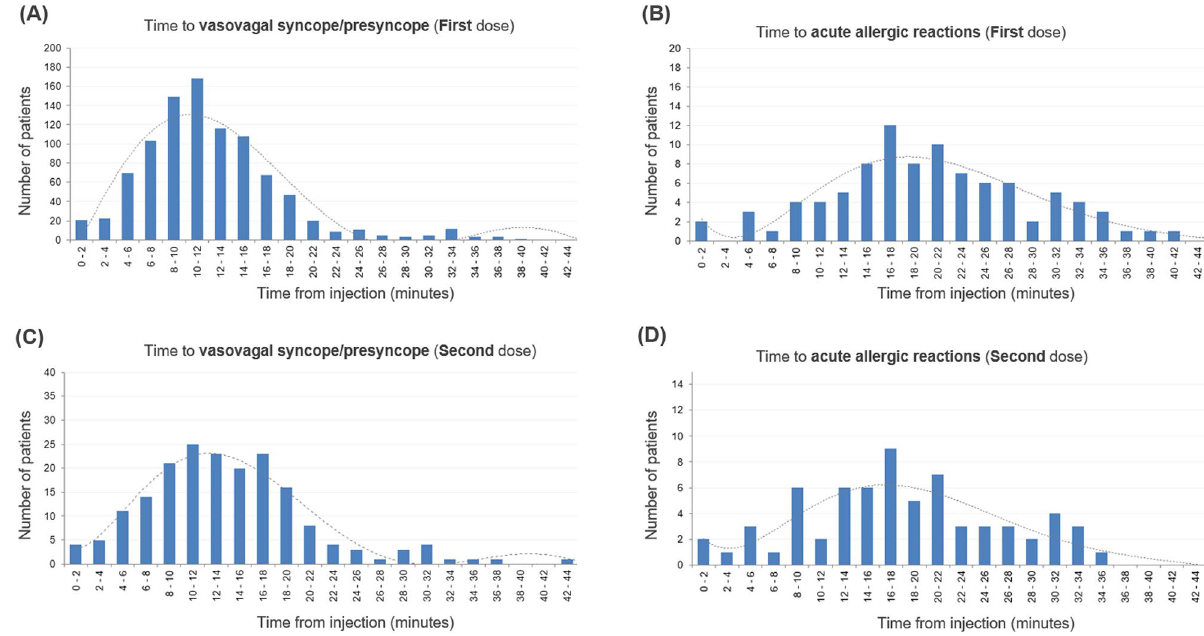
Figure 3. Timing of acute adverse event by age group. Histograms for the time from the vaccine injection to the occurrence of the acute adverse events after the first vaccine dose ( A , B ) and after the second vaccine dose ( C , D ) are shown. The peak time of occurrence of vasovagal syncope/presyncope was between 10 and 12 min after the injection, and that of acute allergic reactions was between 16 and 18 min after the injection. The figure was created using Microsoft Office Excel 2016 software (https:// www. micro soft.